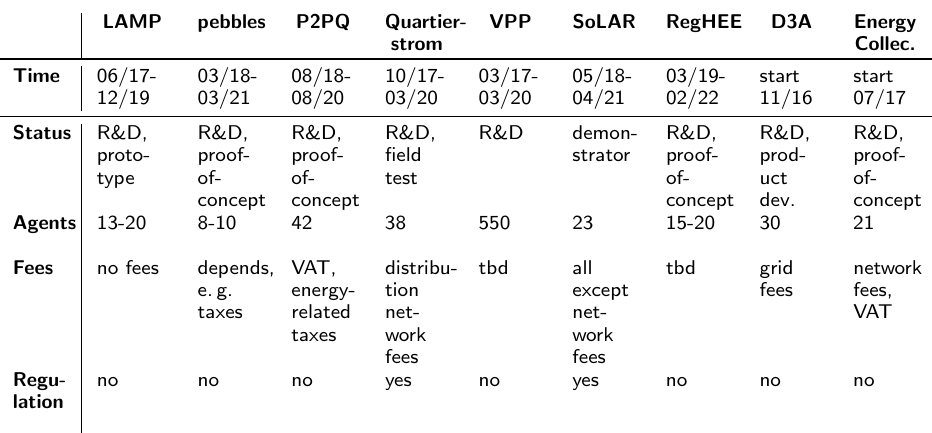
Table 2 Overview of 9 LEM implementation projects in the DACH+ region after [18]. LAMP pebbles P2PQ Quartier- VPP RegHEE strom